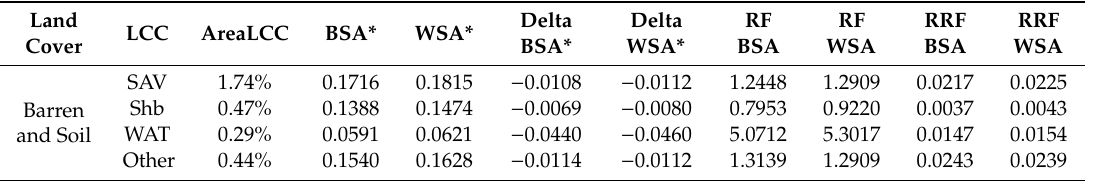
Table 3. Surface albedo variation and radiative forcing a ff ected by land cover changes in the TP between 2000 and 2019; BSA* = average BSA, WSA* = average WSA; Area LCC = surface area a ff ected by the land cover change (LCC) from 2001 to 2019; Delta BSA* = the BSA variation a ff ected by the LCC; Delta WSA* = the WSA variation a ff ected by the